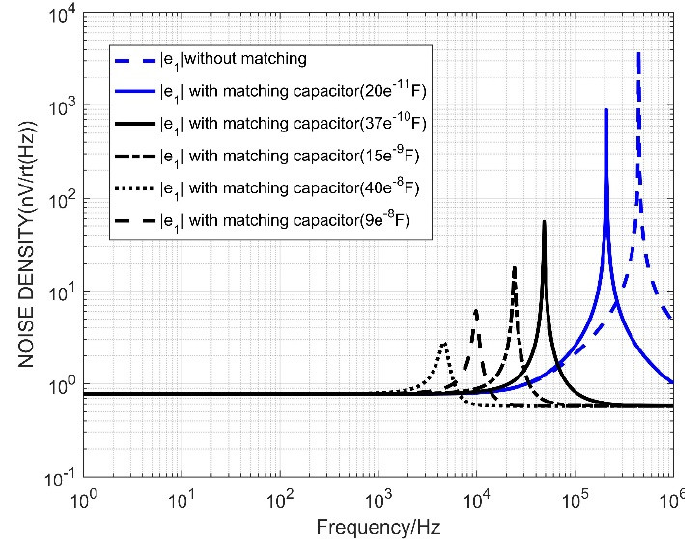
Figure 11. Noise distribution map with matched capacitive sensor.